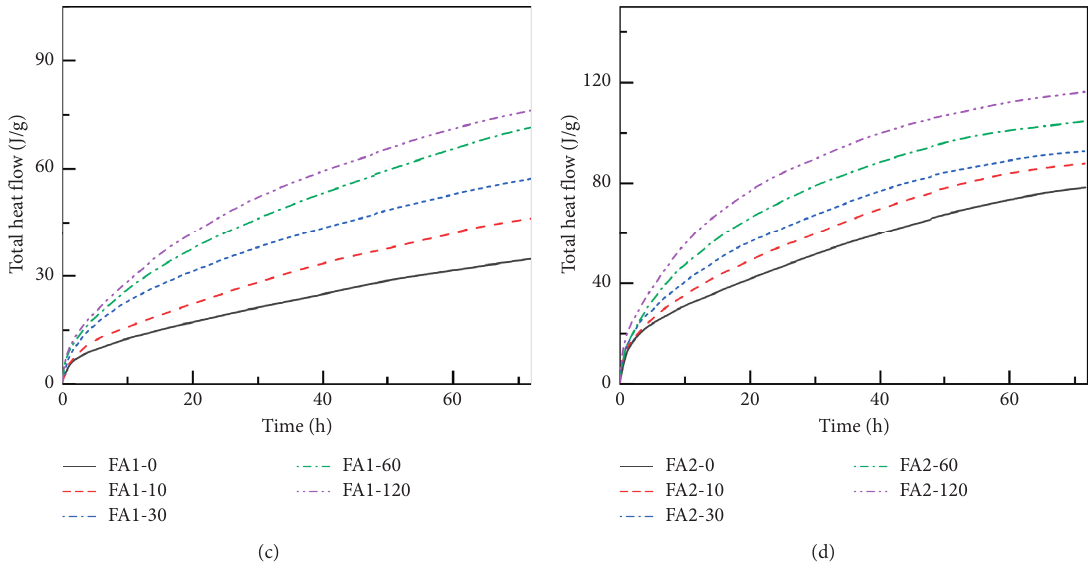
Figure 7: Calorimetry test results: (a, b) heat flow rate and (c, d) cumulative heat release.